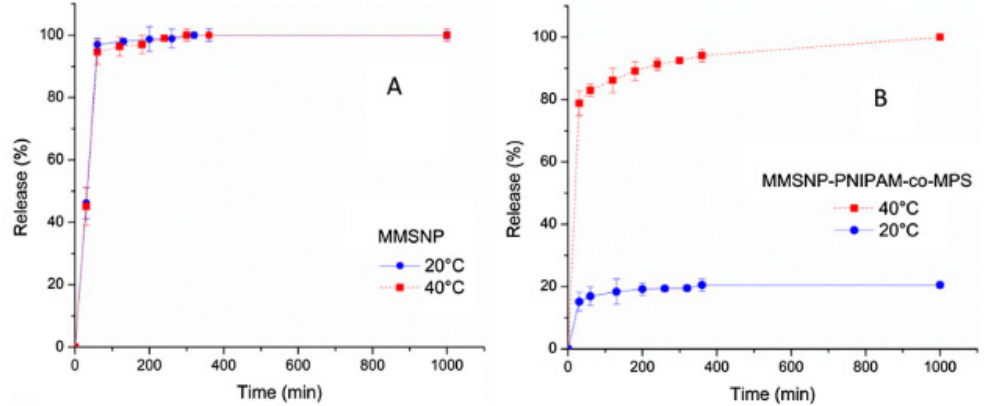
Figure 8. Ibuprofen release curves ( A ) nanosilica particles. ( B ) PNIPAM grafted nanosilica particles at 20 °C (blue) and 40 °C (red) [75]. Reprinted from Journal of Colloid and Interface Science, 544, M. M. E. Peralta et al., Synthesis and in vitro testing of thermoresponsive polymer-grafted core-shell magnetic mesoporous silica nanoparticles for efficient controlled and targeted drug delivery, 198–205, Copyright (2019), with permission from Elsevier.